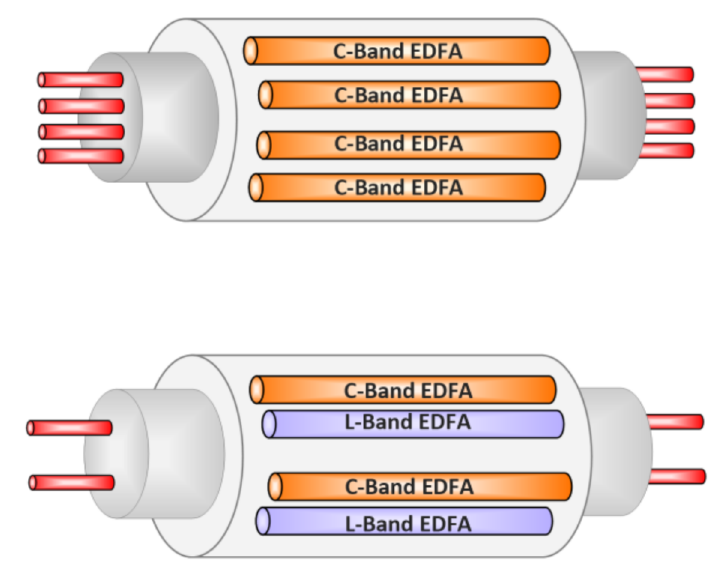
Figure 20. × Tb/s capacity at the cost of 4 fiber pairs (C Band only) on top, × Tb/s capacity at the cost of 2 fiber pairs (C + L Band) band bottom part of the